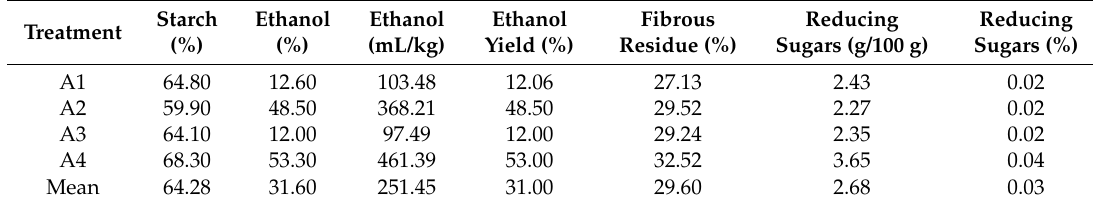
Table 3. Values after distillation.